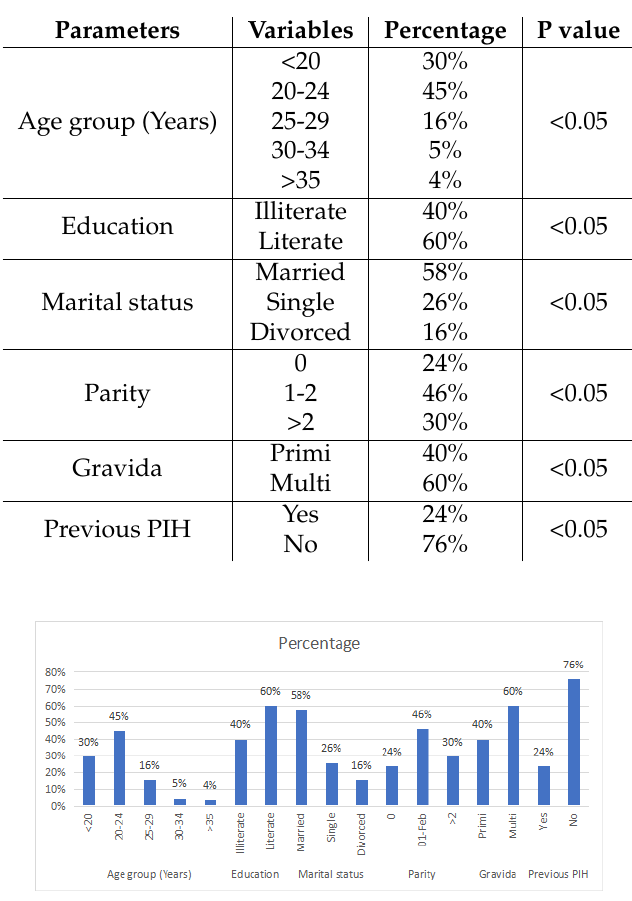
Table 1. Parameters recorded in patients